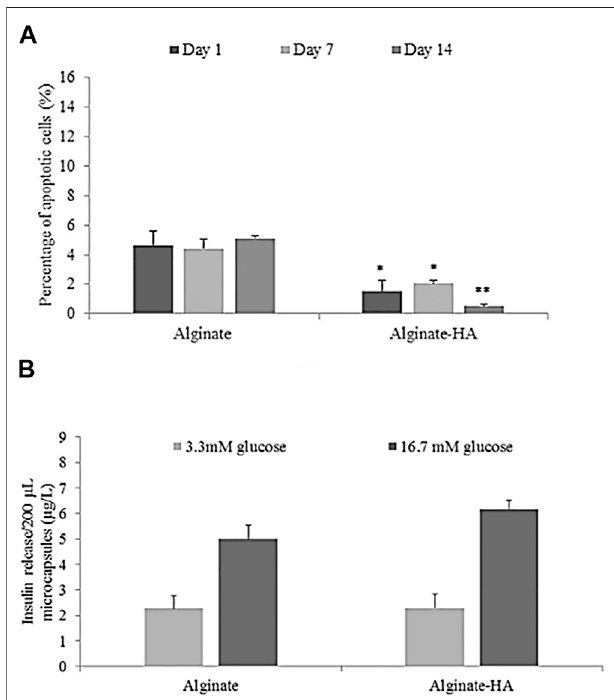
FIGURE 3 | Cell viability (A) and insulin secretion (B) from hyaluronic acid-alginate hybrid microparticles encapsulating islets (Cañibano-Hernández et al.,